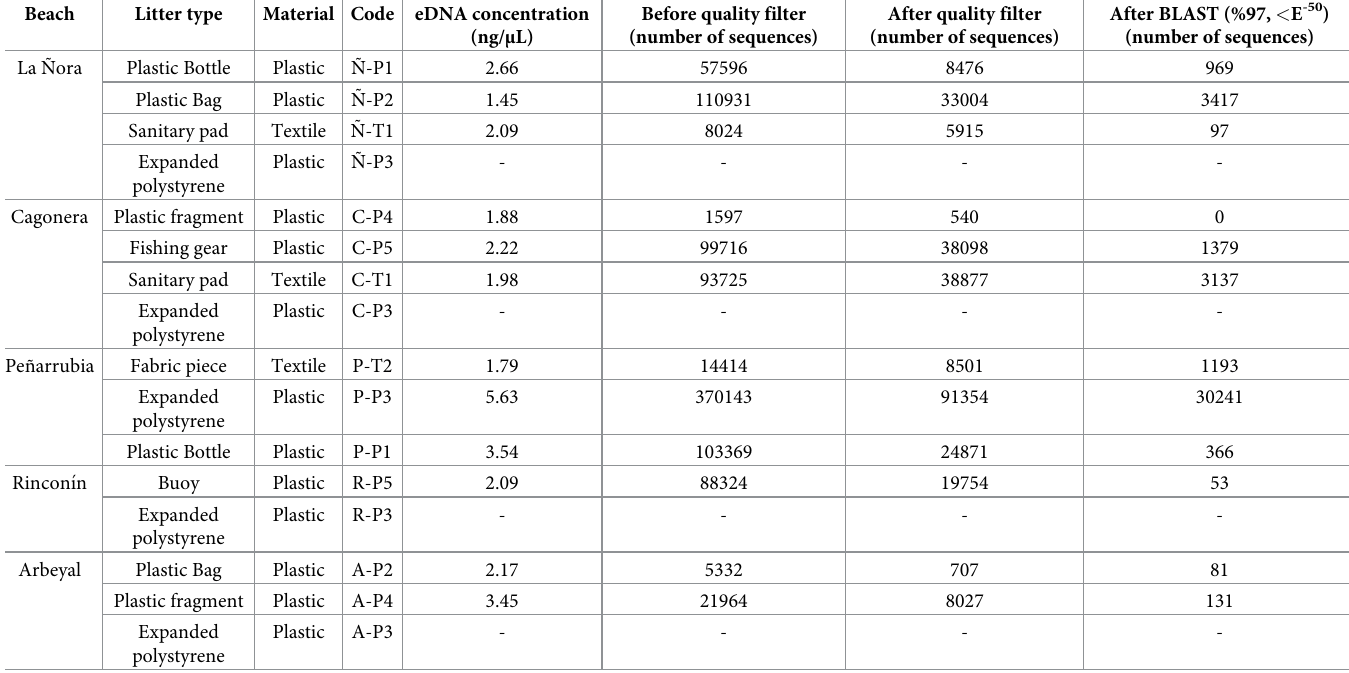
Table 2. Raw and filtered NGS results. Litter surfaces used for biofilm analyses with the codification for each liter item (initial letter of the beach; P for plastic, T for tex- tiles) concentration of eDNA as ng/ μ L, number of reads obtained before and after quality filters, and number of sequences assigned taxonomically after the final